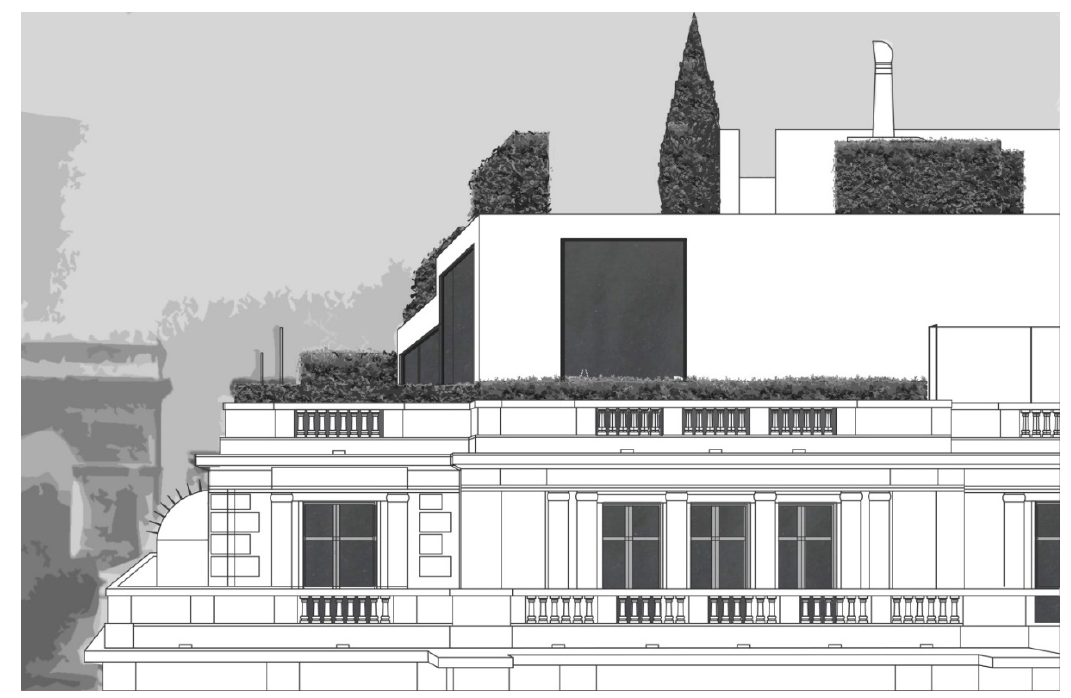
Figure 1. The superstructure over the tenement house according to the design of Le Corbusier and Pierre Jeanneret. Own graphic design 2022.